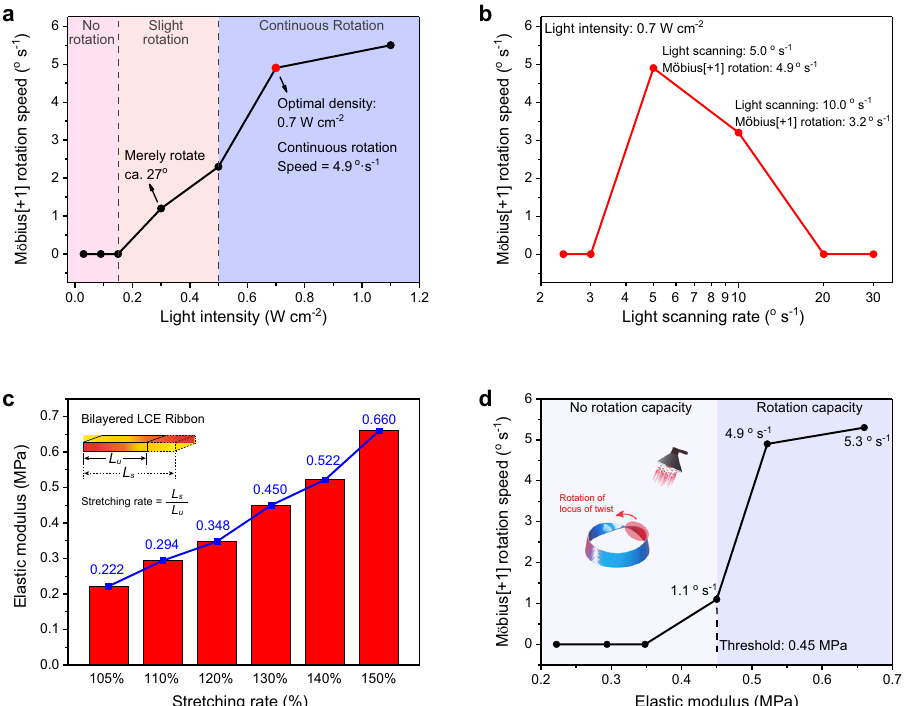
Fig. 6 The correlation between NIR light intensity, light scanning rate, ribbon elasticity and the rotation speed of C-Möbius[ + 1] actuators. a Rotation speed of a Möbius actuator as a function of 808 nm NIR light intensity. b Rotation speed of a Möbius actuator plotted against the NIR light scanning rate. c Elastic modulus of the bilayered LCE ribbon with varied stretching rate. d Actuator rotation speed diagram plotted against the varied elastic modulus of bilayered LCE